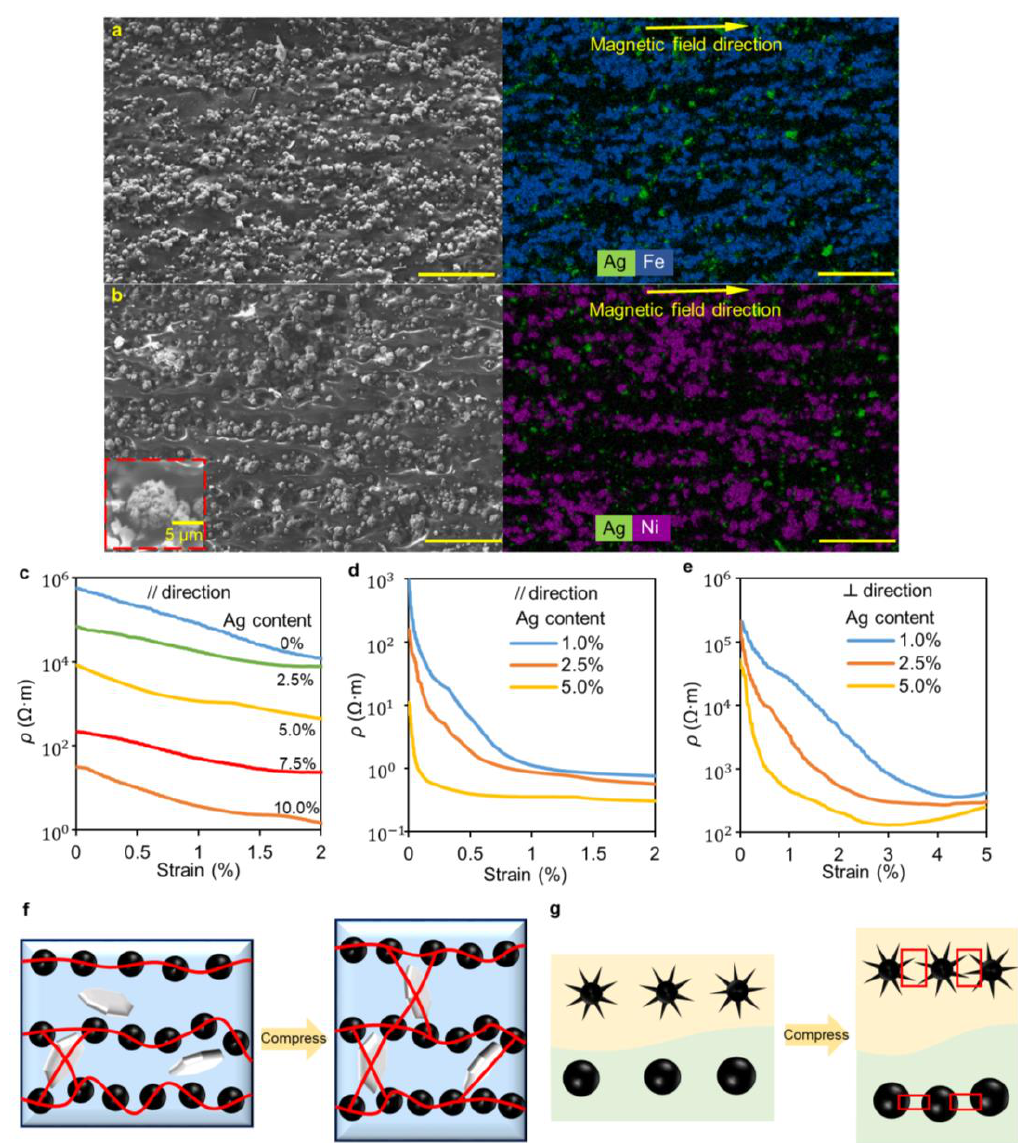
Figure 3. SEM images and EDS analysis of the cross-section of ( a ) AP-Fe-Ag 2.5 , and ( b ) AP-Ni-Ag 2.5 . The inset shows an SEM image of a Ni particle. Resistivity-strain curves of ( c ) AP-Fe-Ag y , and ( d ) AP-Ni-Ag y samples under compression along the alignment direction (magnet field direction) and ( e ) AP-Ni-Ag y samples perpendicular to the alignment direction. Illustrative schematics show the change in the microstructure of the ( f ) AP-Fe-Ag y , and ( g ) AP-Ni-Ag y under compression. The scale bars are 50 µ